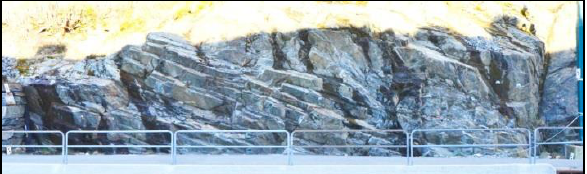
Figure 1. Mannsverk outcrop, 20m-wide, 3-m-high, North is to the left, the outcrop is facing West. The geological scan line was surveyed slightly above the hand rail, from this